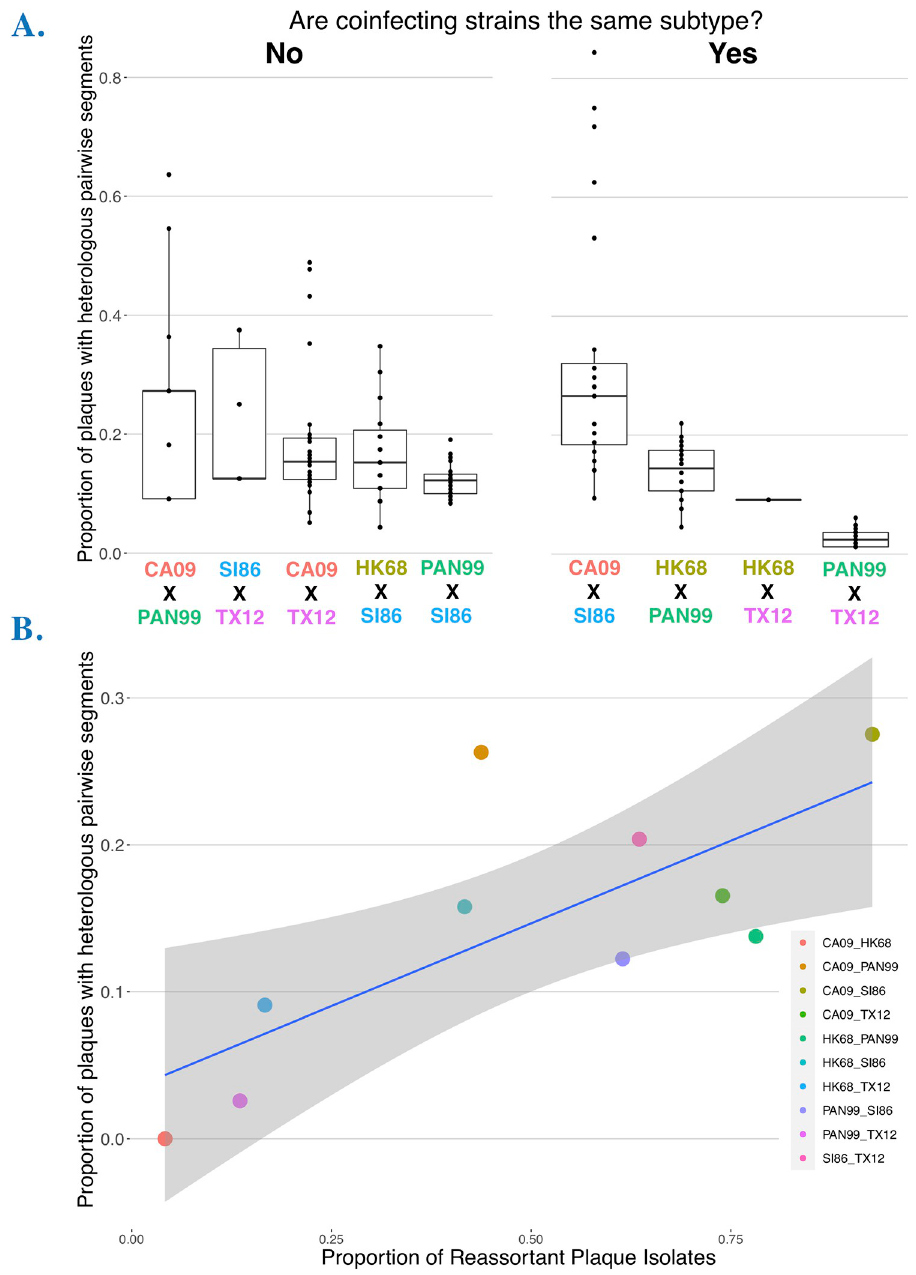
Fig 8. Pairwise segment combinations across experimental coinfections. A. Proportion of plaque isolates that had heterologous (i.e. reassortant) genotypes for each pairwise segment combination, represented by points. The left panel shows intersubtype experimental coinfections (i.e. H1N1xH3N2) and the right panel shows intrasubtype (i.e. H1N1xH1N1 or H3N2xH3N2). B. Relationship between reassortment frequency (x-axis) and the average proportion of plaque isolates with heterologous genotypes (across all pairwise segment combinations for each experimental coinfection). Each point represents an experimental coinfection. https://doi.org/10.1371/journal.ppat.1011155.g008 unique genotypes (range: 1–36) from 12–88 isolated plaques with complete eight-segment genotypes (progeny with missing segment data were excluded). The frequency of reassortment showed a posi- tive correlation with genotype richness ( Fig 9B , Multiple R 2 = 0.8366, p < 0.001).